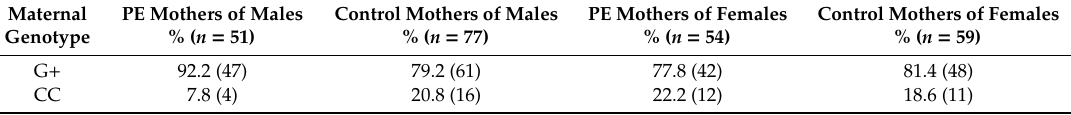
Table 2. Frequency distribution of High and Low CD99 expresser genotypes among subgroups of mothers.